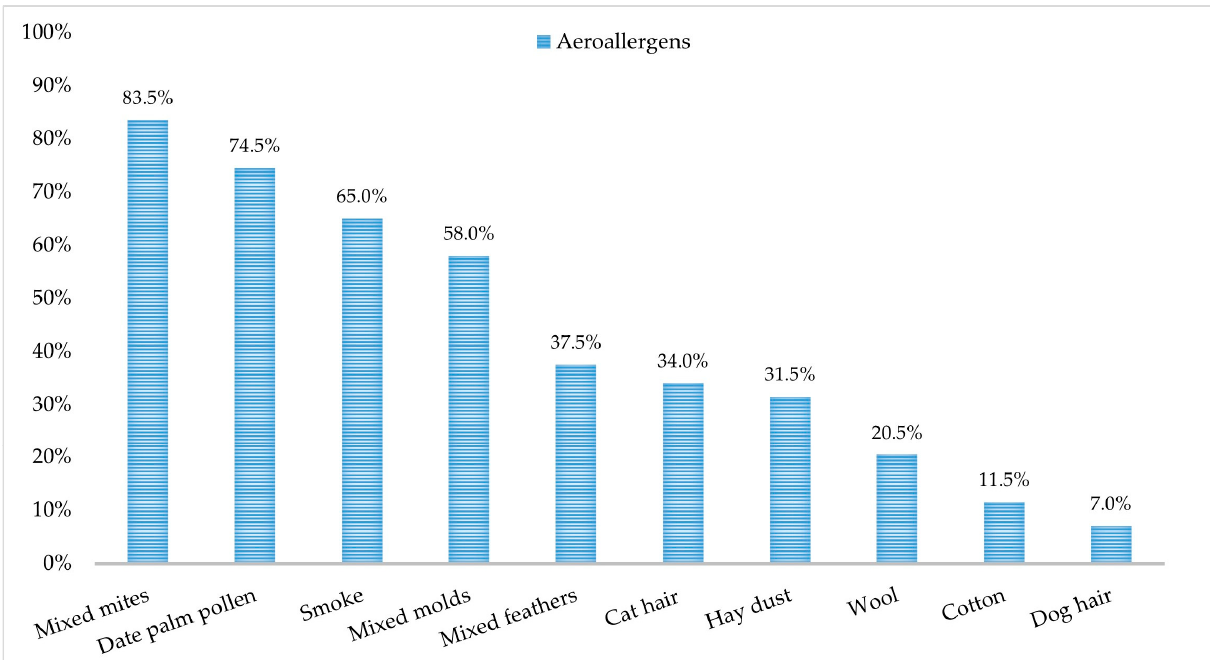
Figure 1. Aeroallergens sensitization patterns by skin prick test in the studied patients (N = 200).